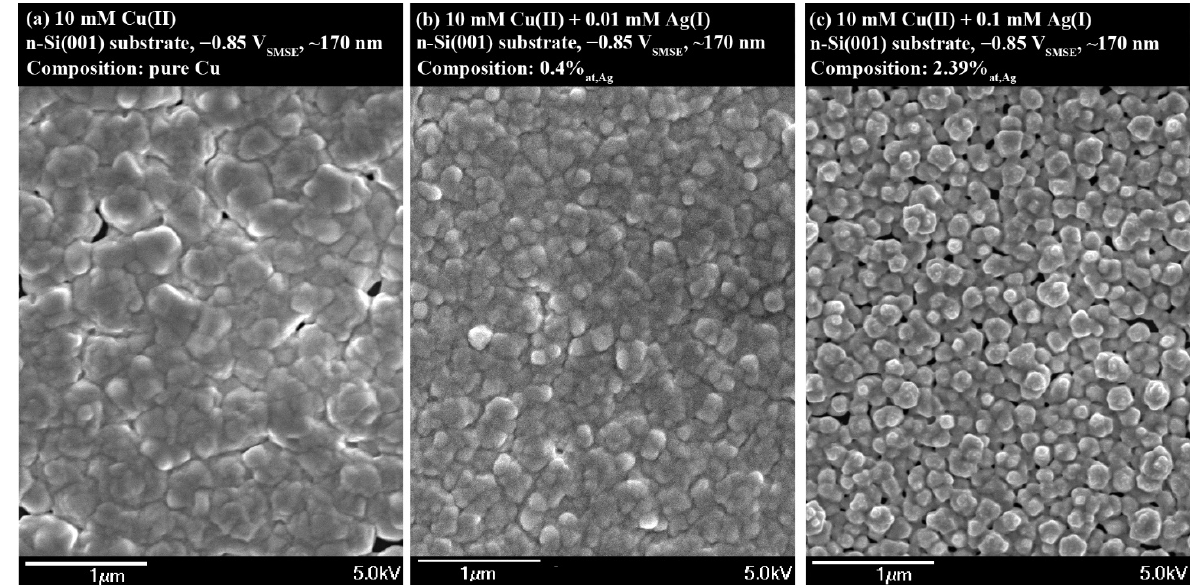
Figure 4. The morphology of thick films deposited from 0.5 M H 2 SO 4 + 10 mM CuSO 4 solutions with addition of 0~0.1 mM AgNO 3 at n-Si(001) substrate, nominal thickness of films is about 170 nm.